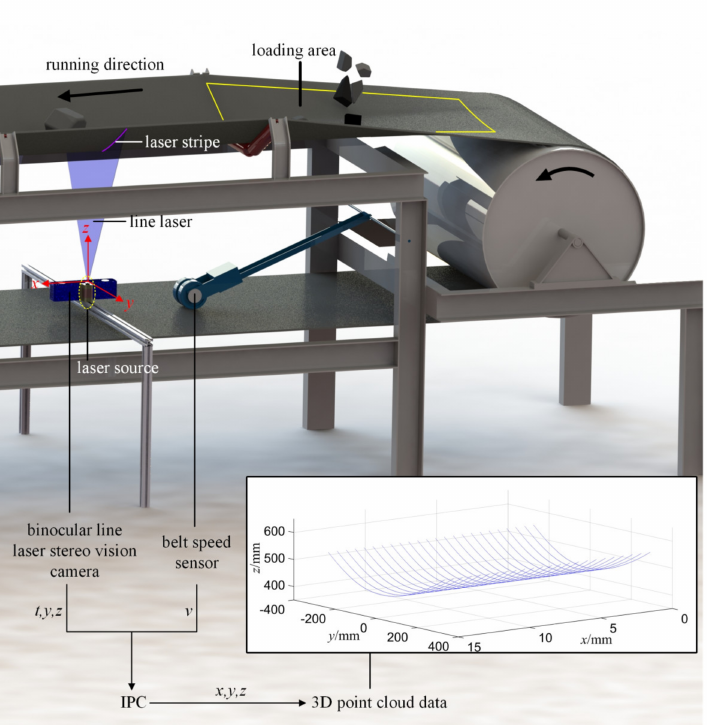
Figure 1. System setup and data acquisition process; IPC, industrial personal